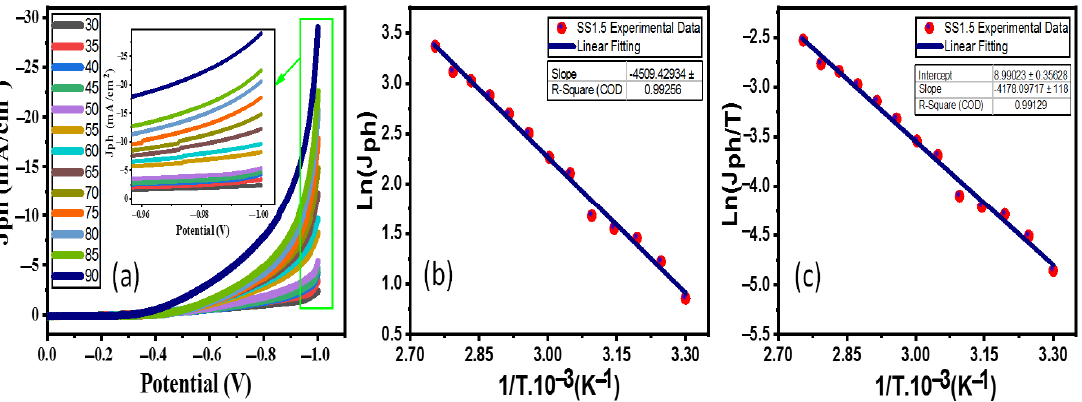
Figure 6. Effect of temperature for the SS1.5; ( a ) the change in J ph -V behaviors at distinctive temperatures, ( b ) Ln ( J ph ) versus ( T −1 ), and ( c ) Ln ( J ph . T −1 ) versus ( T −1 ).